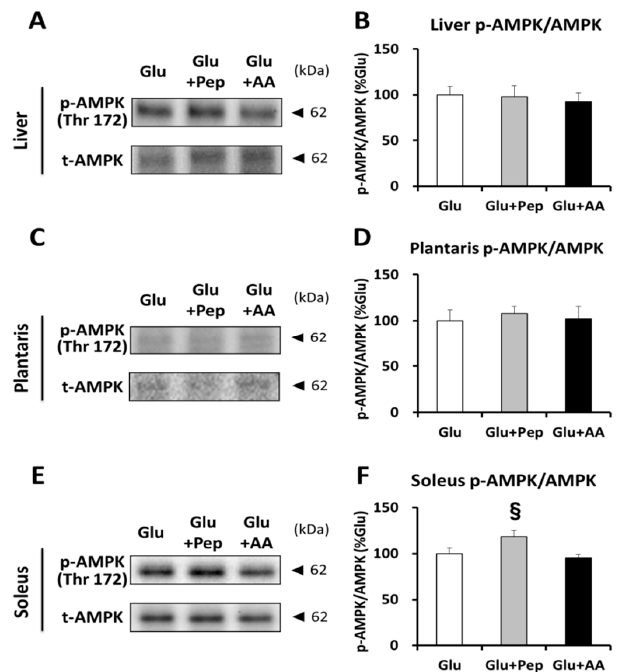
Figure 7. AMPK phosphorylation state. ( A ) Representative blots for p-AMPK and total-AMPK in the liver; ( B ) AMPK phosphorylation state in the liver; ( C ) Representative blots for p-AMPK and total-AMPK in the plantaris muscle; ( D ) AMPK phosphorylation state in the plantaris muscle; ( E ) Representative blots for p-AMPK and total-AMPK in the soleus muscle; ( F ) AMPK phosphorylation state in the soleus muscle. Values are presented as mean ± SEM. § significantly different from the Glu + AA group ( p < 0.05).